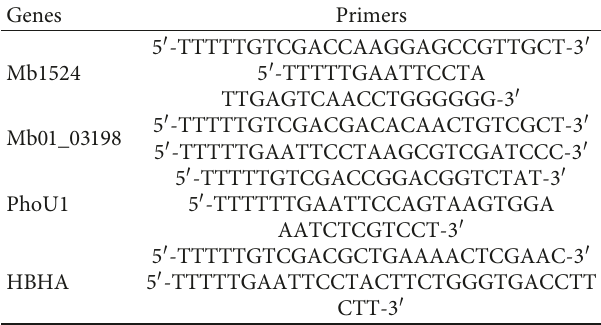
Table 2: Primers used for construction of recombinant M. bovis BCG surface antigens in the pET6xHN_N vector of E. coli .